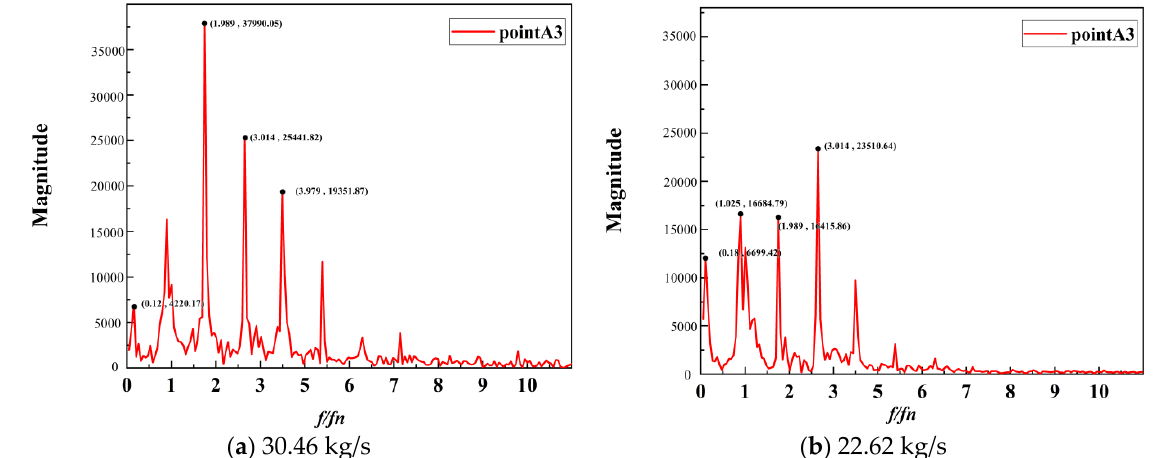
Figure 14. Amplitude spectra of monitoring point A3 underthe off-design conditions.